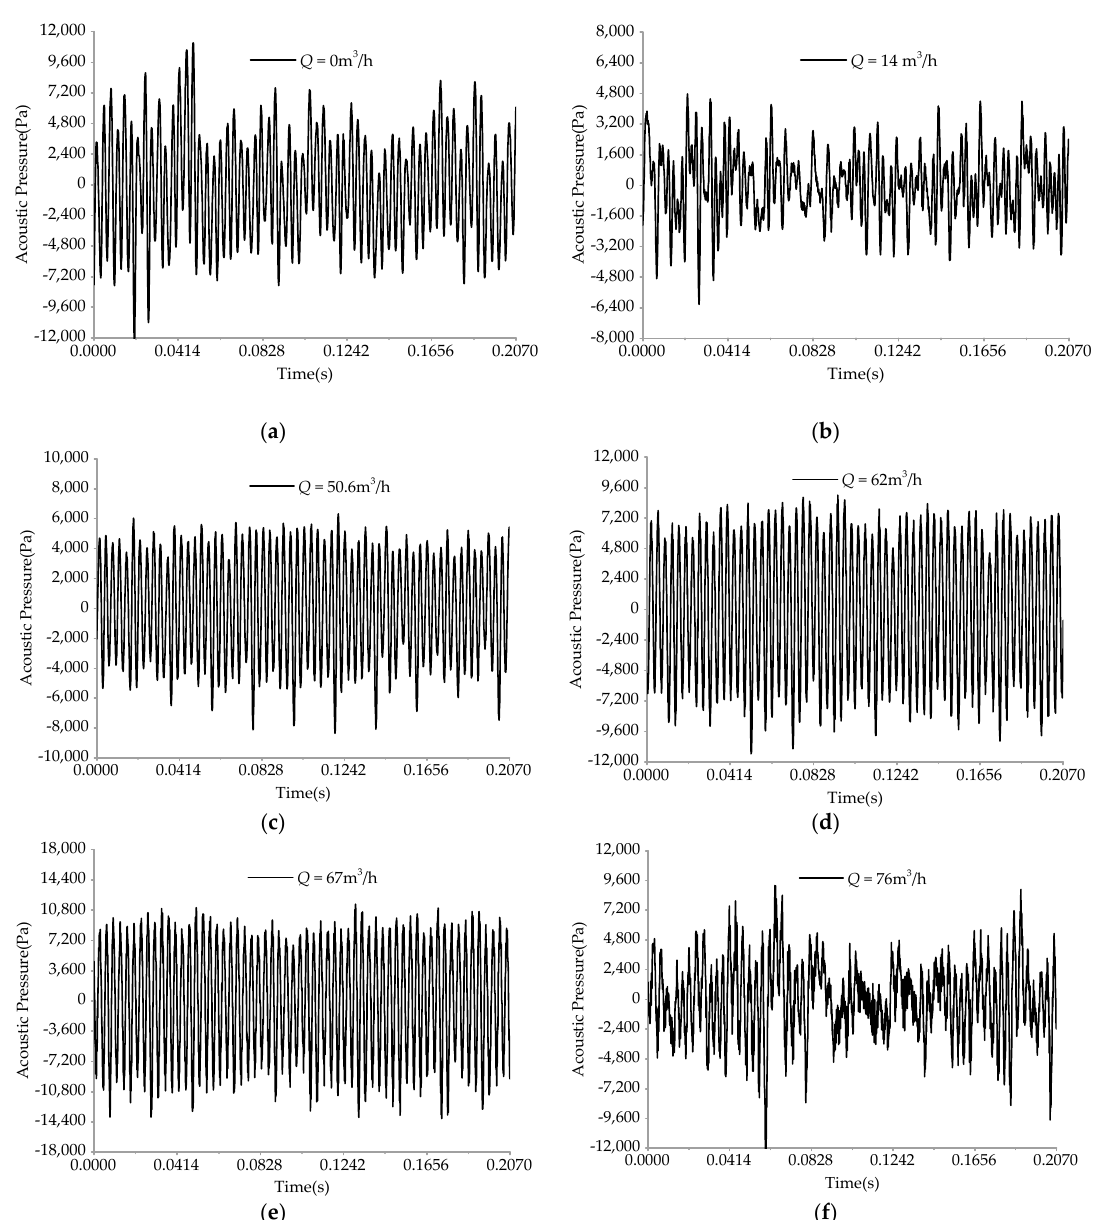
Figure 10. Time domain of the acoustic pressure measured by pump inlet hydrophone 2 at different flow rates. ( a ) Q = 0m 3 /h; ( b ) Q = 14m 3 /h; ( c ) Q = 50.6m 3 /h; ( d ) Q = 62m 3 /h; ( e ) Q = 67m 3 /h; ( f ) Q = 76m 3 /h.